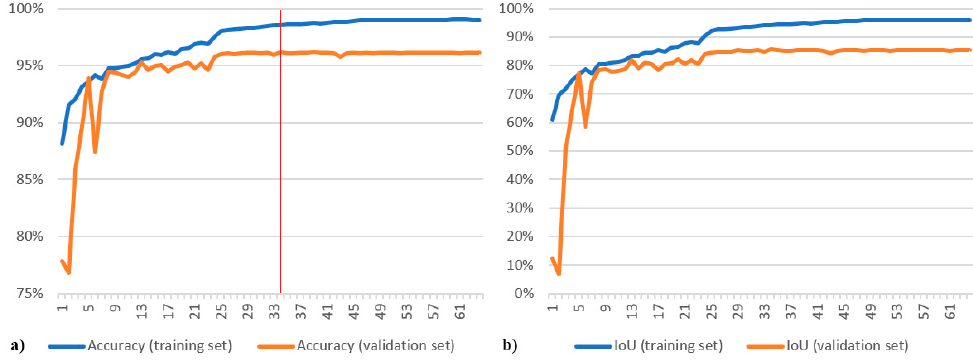
Figure 8. Accuracy ( a ) and IoU ( b ) metrics for the original model without dropout ( n = 32).